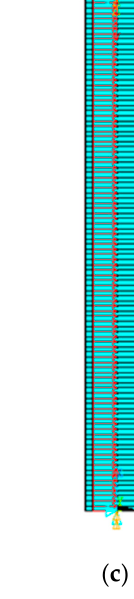
Figure 1. Derrick force diagram: ( a ) marine derrick; ( b ) diagram of the derrick leg; and ( c ) finite element model of the rod of derrick leg.